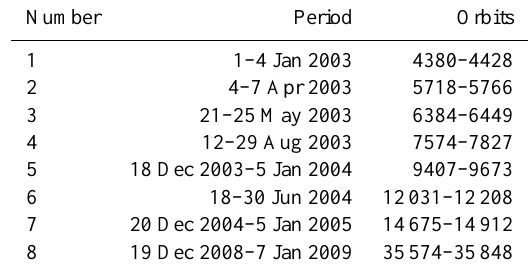
Table 1. Decontamination events of the SCIAMACHY instrument from 2003–2012. The dates are given together with the correspond- ing orbit